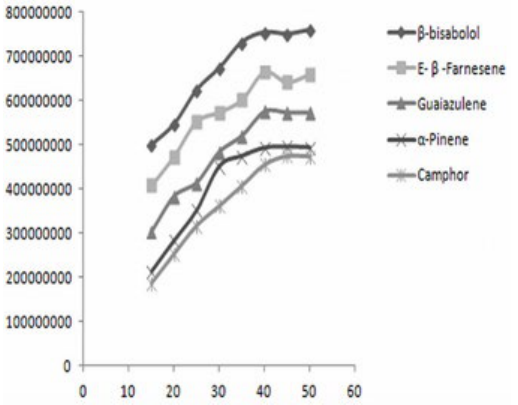
Fig. 4. Effect of added water on the extraction efficiency. (X=mL of water, Y=area